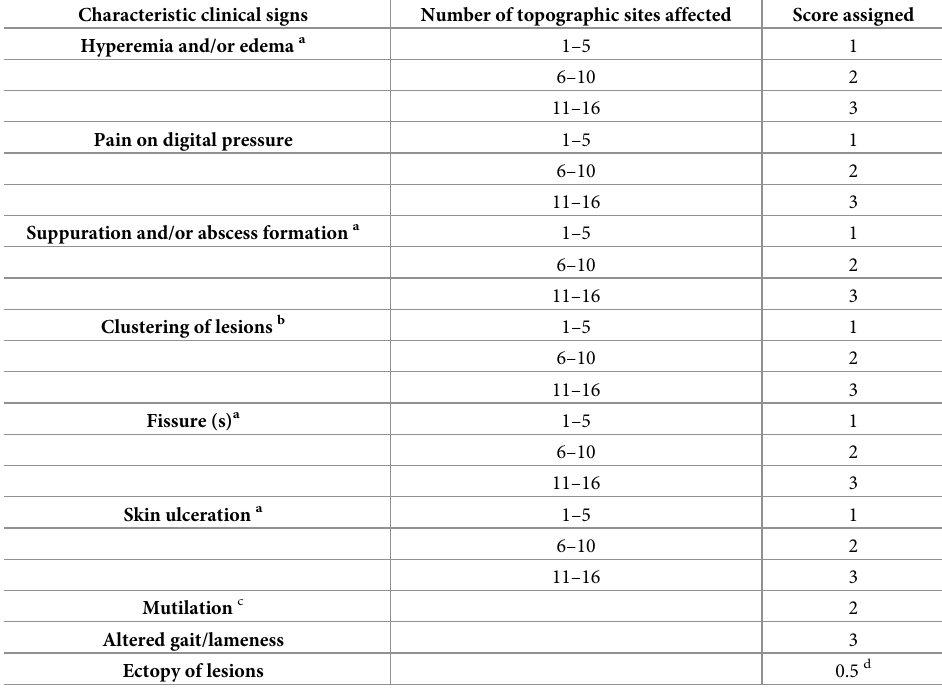
a Irrespective of number of foci and size of the area involved on a designated topographical site. b Three or more lesions in close proximity (1–2 mm apart). c Mutilation of lesions reflects intense itching. d Therefore, the maximum score (SCADT) for an individual dog will be 27